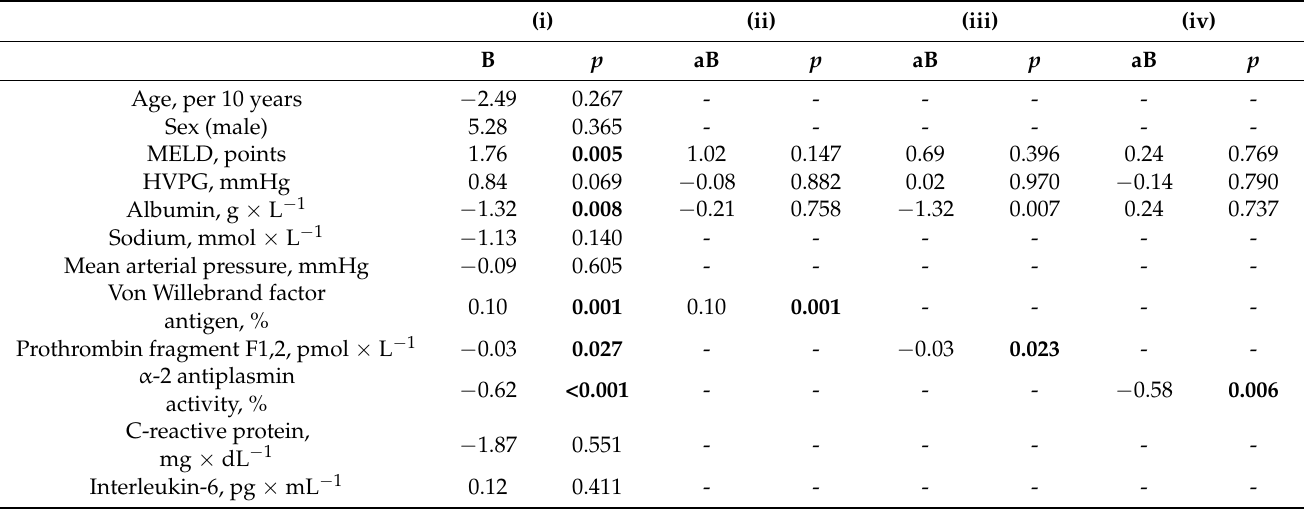
Table 3. Assessment of independent determinants of plasma levels of ACE activity in cirrhotic patients by multiple linear regression analysis: (i) univariate analysis; and adjusted models (ii) including Von Willebrand factor antigen, (iii) prothrombin fragment F1,2; or (iv) α -2 antiplasmin activity. Bold font shows statistically significant differences between